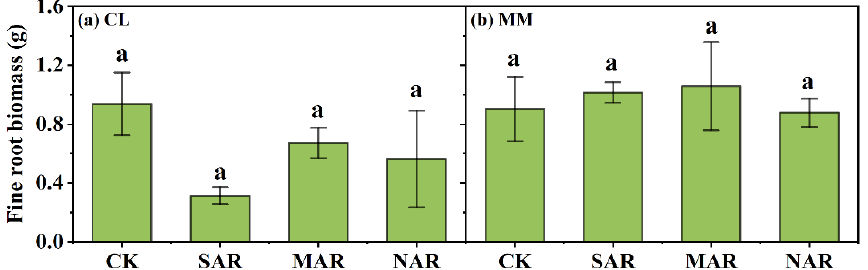
Figure 6. Fine root biomass under different types of acid rain in Cunninghamia lanceolata (Lamb.) Hook. ( a ), and Michelia macclurei Dandy ( b ) plantations. Vertical bars represent standard errors ( n = 4). Means followed by a common letter are not significantly different among different acid rain treatments ( p < 0.05).